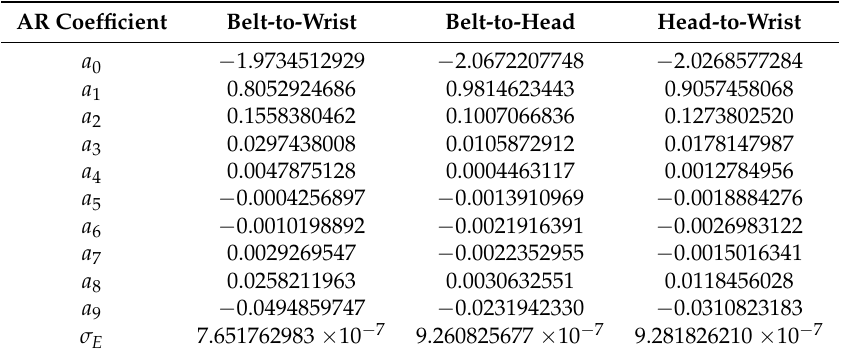
Table 2. Table of auto-regressive model weights for on-body